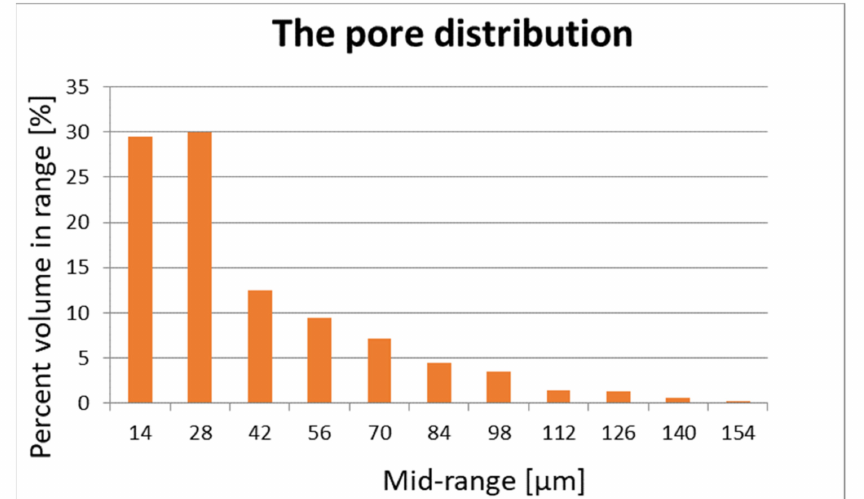
Figure 2. Pore distribution of sample 2.